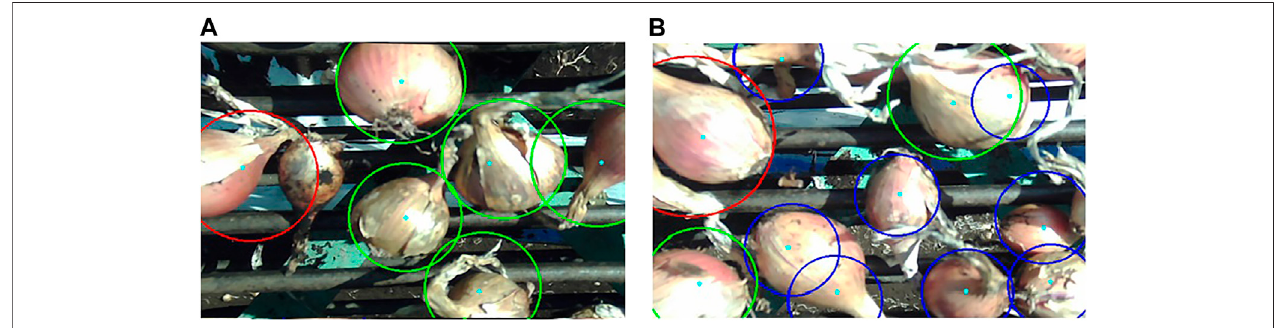
FIGURE 8 | Two example frames showing onion detection results. Size categories are indicated by colored circle boundaries (Blue (cid:2) small, Green (cid:2) medium, and Red (cid:2) large).